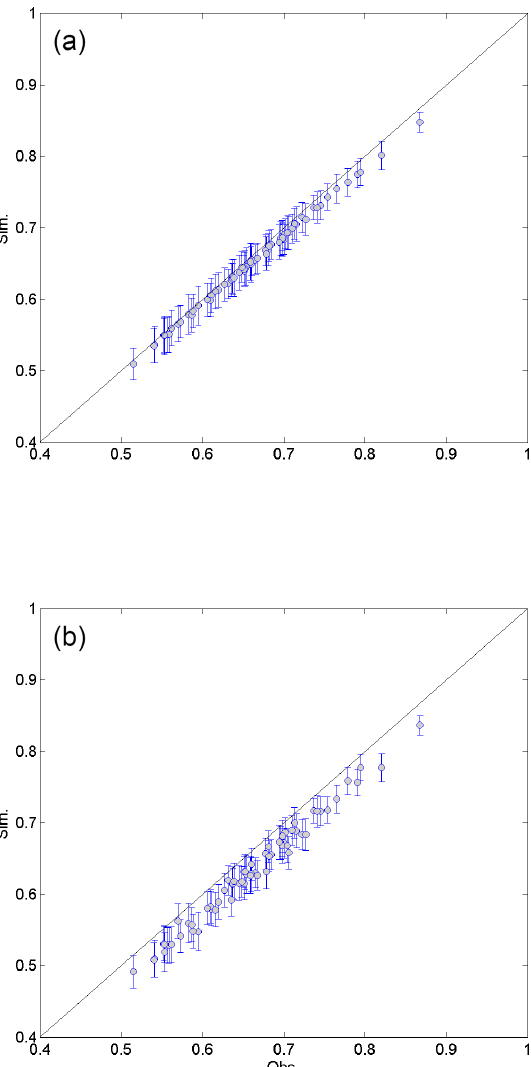
Figure 8. Scatterplot of cross-correlations between 12 weather stations for the observed data ( x coordinate) and the generated data ( y coordinate) from the DKNNR model (a) and the MONR model (b) . The cross-correlations from 100 generated series are av- eraged for the filled circle, and the error bars upper and lower ex- tended lines indicate the range of 1.95 times the standard deviation.